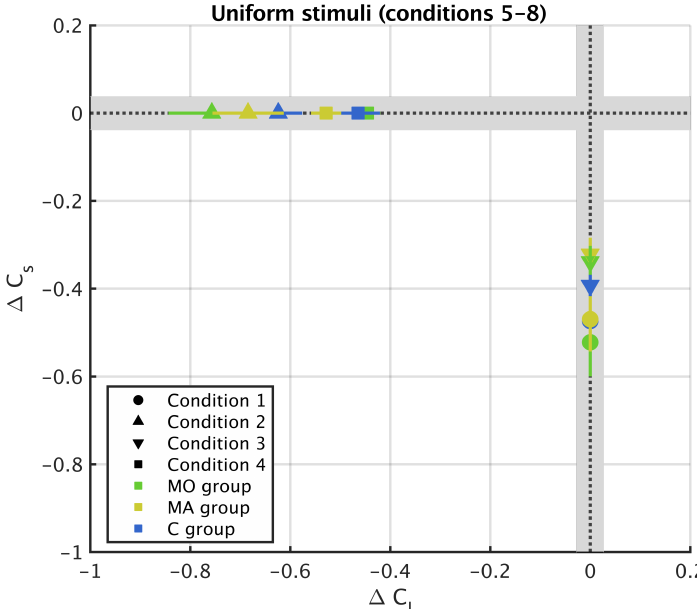
Figure A2. In this figure, we present the psychophysical results for uniform surrounds for stimuli composed by 11 stripes. Results are similar to the ones shown in Figure